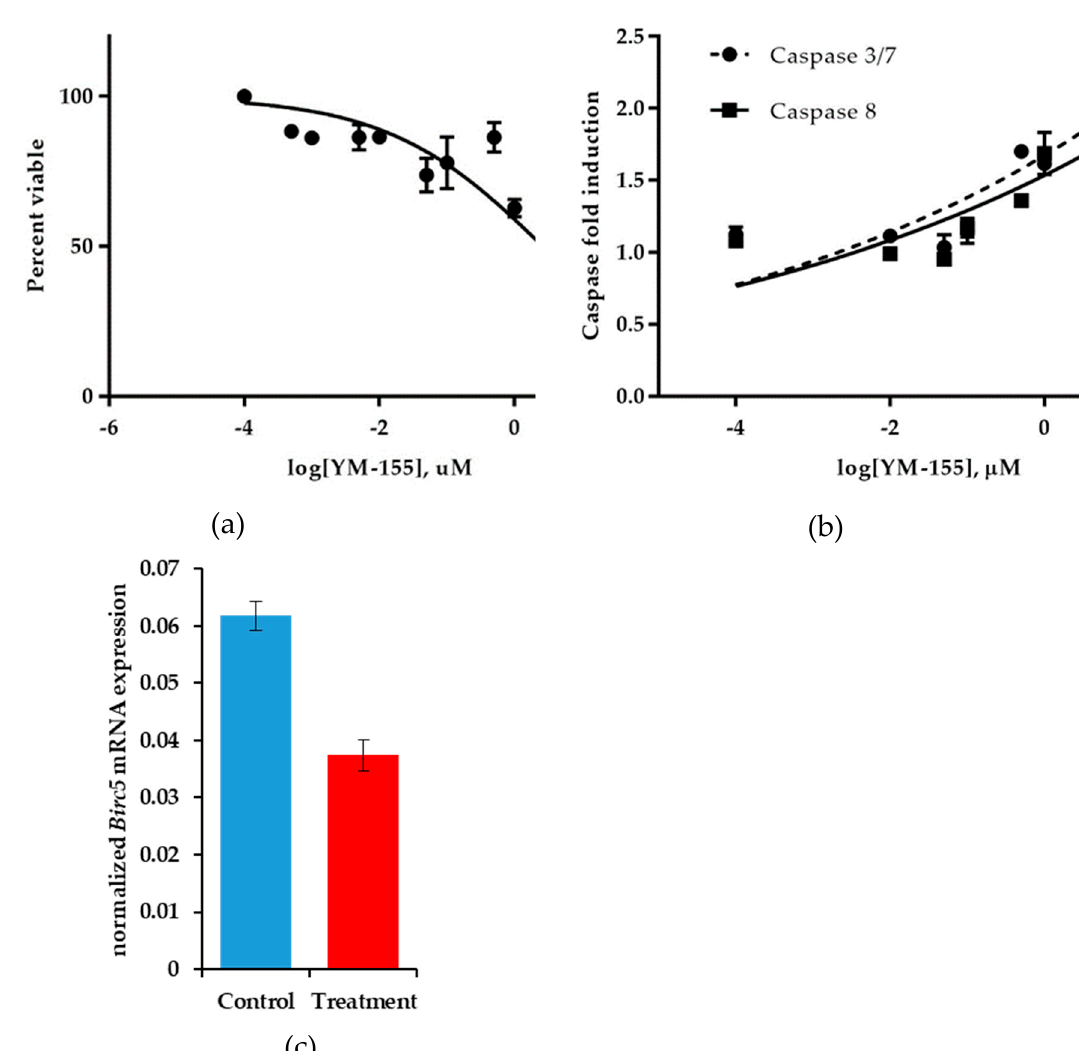
Figure 6. YM155 decreases viability and BIRC5 expression in HS-SY-II cells. ( a ) Cells were treated for 24 h with various concentrations of YM155 and then assayed for the conversion of MTT to formazan and correlated to cell viability. ( b ) Caspase 3/7 & 8 activity detection in response to YM155 treatment. Fold increases are normalized to control treated HS-SY-II cells. Error bars are SDM. ( c ) Normalized mean values for Birc5 expression. BIRC5 was normalized with GAPDH mRNA expression, bars represent the SEM, n = 4 ( p = 0.0006).